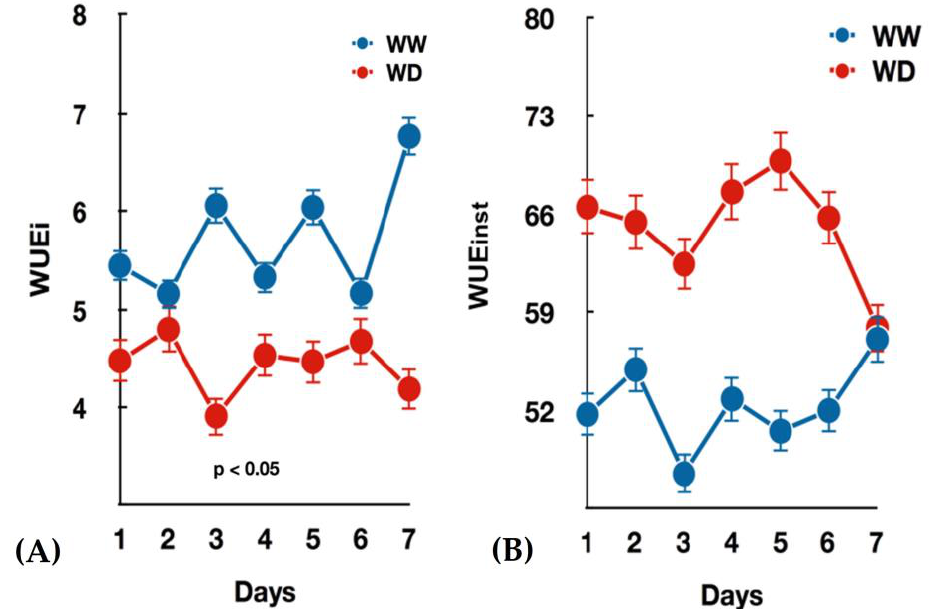
Figure 5. Daily ( A ) seedlings intrinsic water use efficiency (WUE i ) and ( B ) instantaneous water use efficiency (WUE inst ). Blue lines represent well-watered seedlings; red lines represent water-deficit treated seedlings.